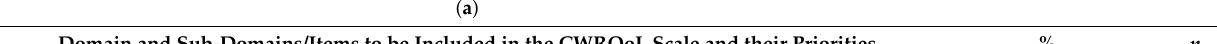
Table 2. ( a ) CWRQoL scale domains and sub-domains content validity results, Stage 3: consensus survey. ( b ) Sub-domains to be excluded from the CWRQoL according to content validity, Stage 3: consensus